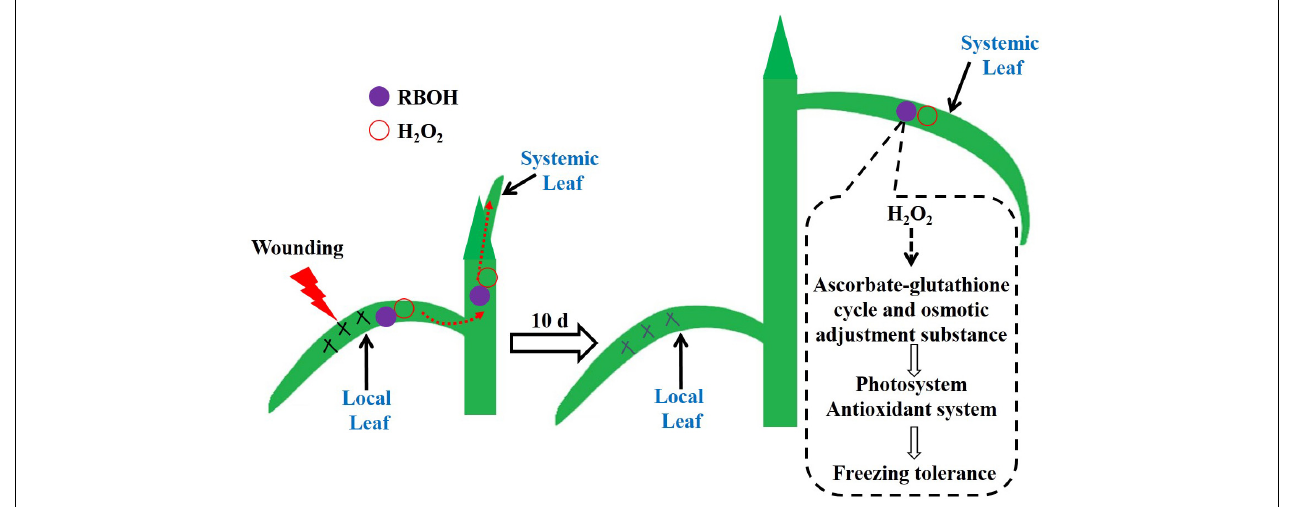
FIGURE 9 | The working model of the mechanical wounding on the local leaves enhancing tolerance to freezing of the newly occurred systemic leaves in wheat. Wounding on the local leaves triggers the accumulation of H 2 O 2 via the NADPH oxidase (RBOH) pathway. The burst of H 2 O 2 functions as a crucial signal molecule being further conducted and amplified in the systemic leaves, which consequently initiates the anti-freezing responses in terms of stimulated antioxidant capacity, accumulation of osmolytes and improved photosynthesis in the systemic